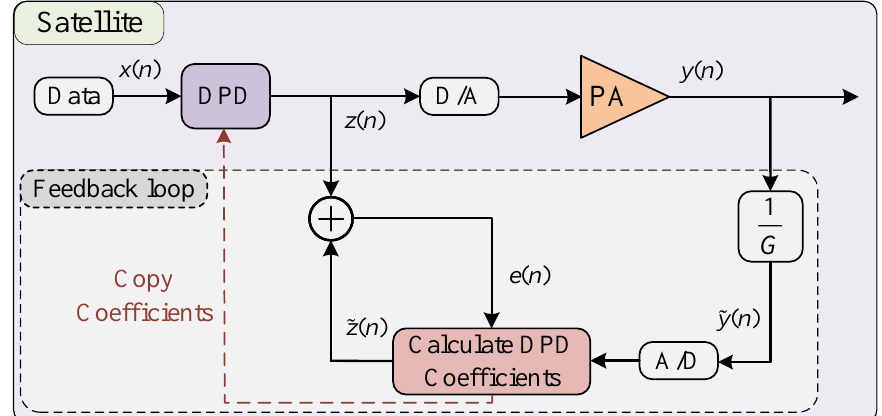
Figure 5. The conventional DPD indirect learning architecture. The indirect learning structure of the proposed JSG-DPD technique is illustrated in Figure 6, in which the pre-distorter is not working until the DPD coefficients are identified. At this time, the input signal of the APA x ( n ) = z ( n ) , z ( n ) is taken as the expected output signal of the DPD coefficients estimation module, and the signal ˆ y ( n ) after noise reduction of the received signal ˜ y ( n ) is taken as the input of the pre-distortion coefficients estimation module, where G is the gain of the pre-PA and linear APA. The signal ˆ y ( n ) is passed through the DPD coefficients estimation module (i.e., post-distortion) to obtain the output signal ˆ z ( n ) , which is subtracted from the desired output signal z ( n ) to obtain the error signal e ( n ) . The adaptive discrimination algorithm obtains the coefficients w of the optimal DPD coefficients estimation module by iterating the error signal. Finally, the coefficient w is directly copied as the coefficient of the pre-distorter to make the pre-distorter operate. It is worth pointing out that for the general Volterra system, the P -order post-inverse is the same as the P -order pre-inverse [30]. Thus, for our application, the post-distortion response is the same as the pre-distortion response, and that is why the coefficients can be copied directly to the pre-distorter before the APA. In addition, the Volterra series are generalized nonlinear models with memory, and DPD of Volterra models is usually implemented using P -order inverse techniques [31].